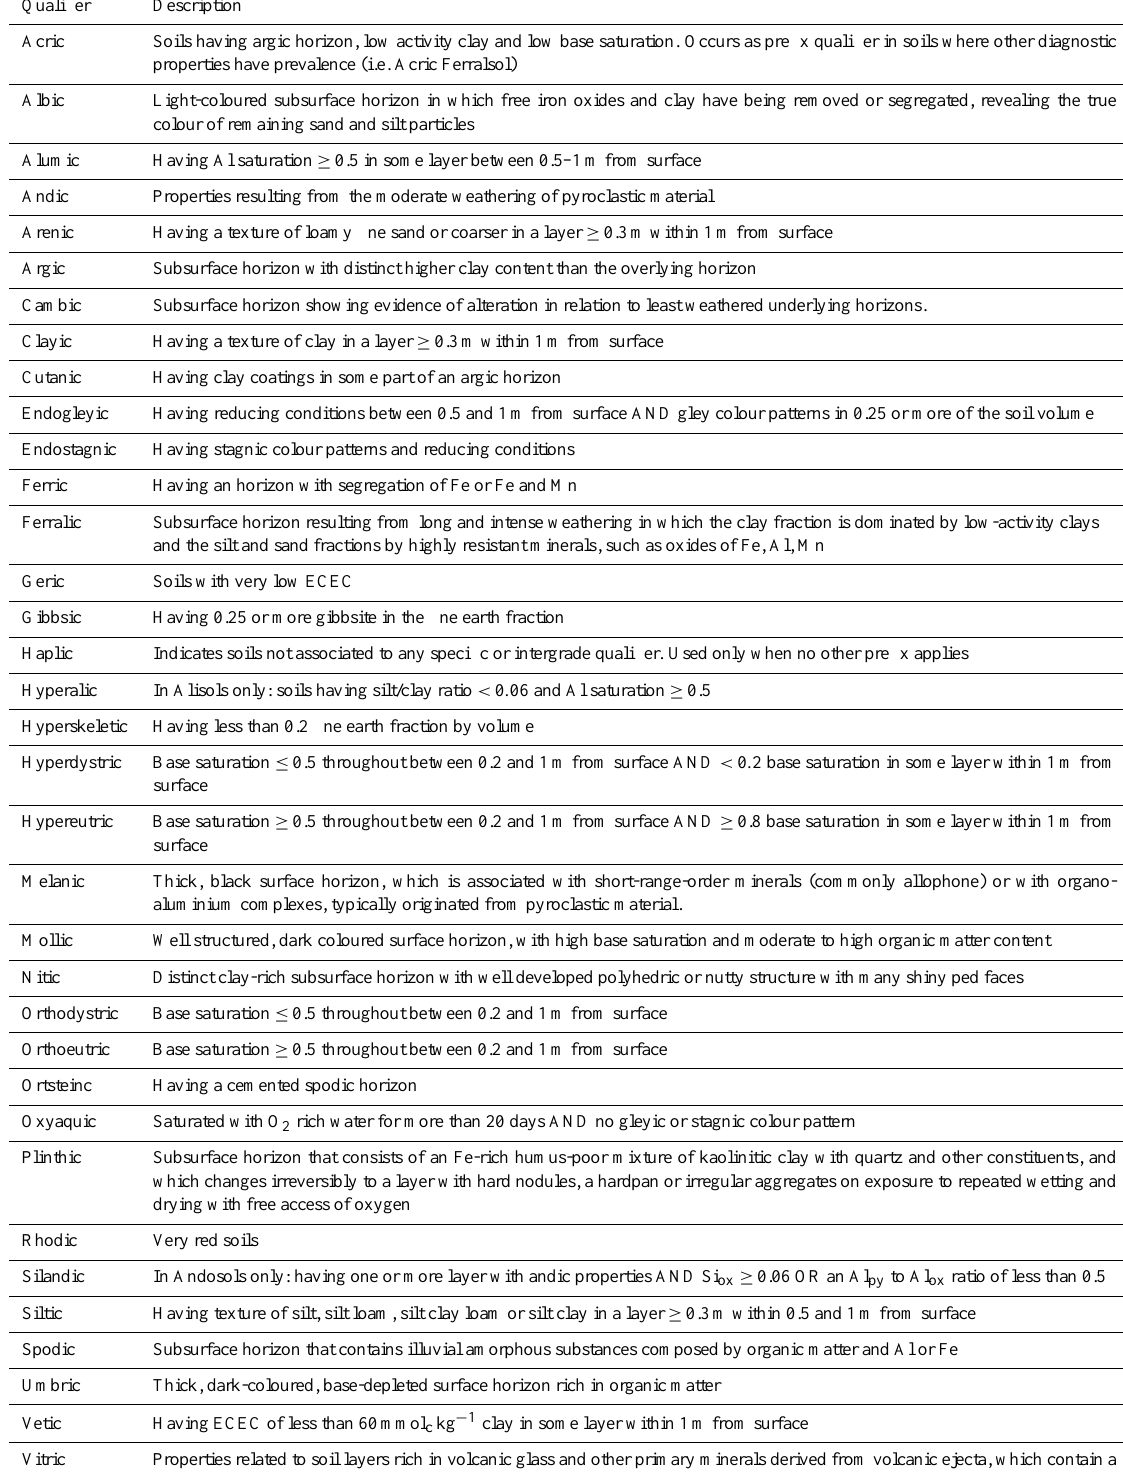
Table 2. Glossary of WRB qualifiers used through the text. For complete description of soil classification terms see IUSS Working Group WRB (2006), report